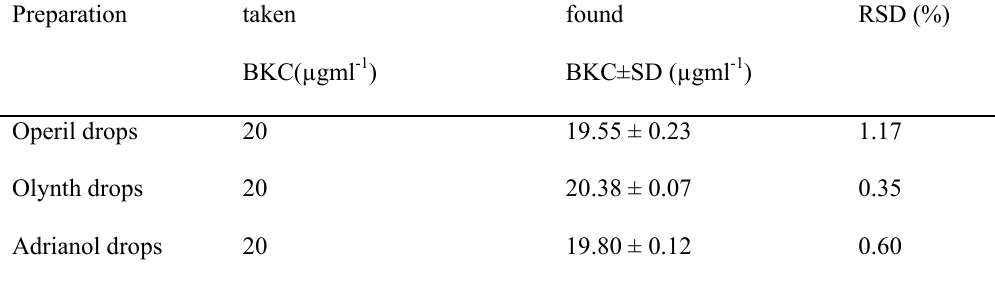
Table 3: Assay results for the determination of BKC in commercial nasal drops. Preparation